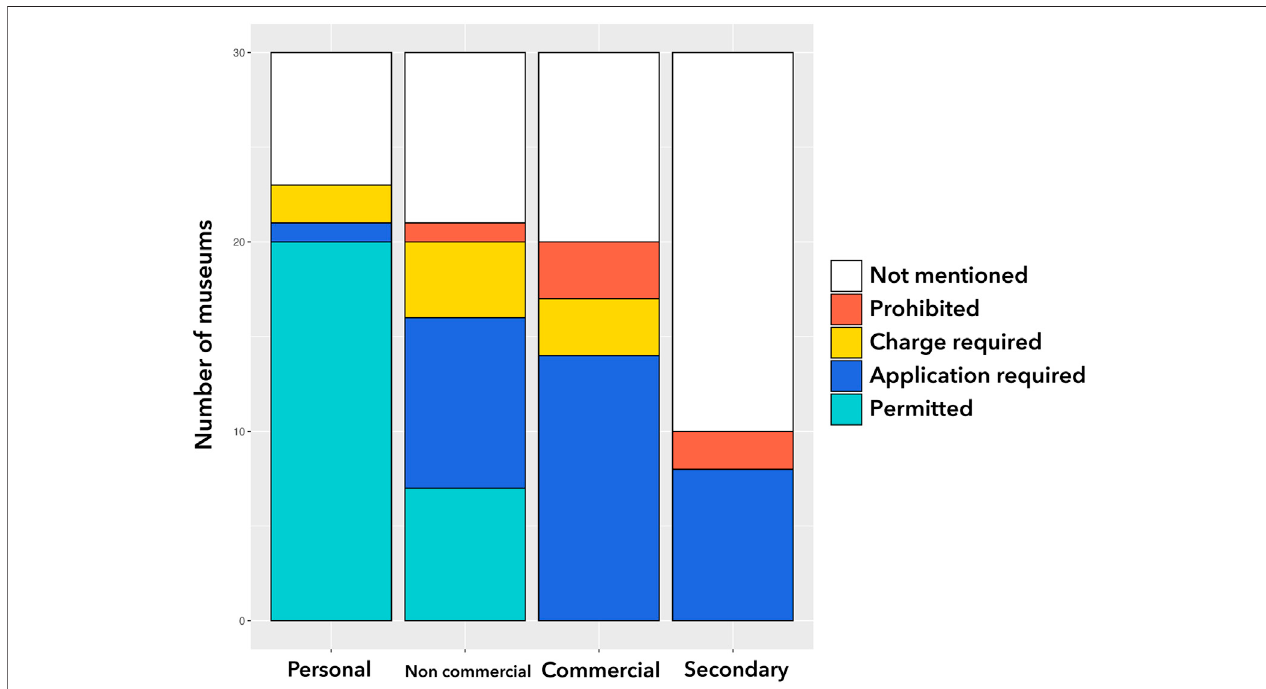
FIGURE 5 | Stacked bar charts of the generalized trend of museum policies. The data were collected from Table 1 . Legends are shown in the right side of the fi gure. These charts were created in R (R Core Team, 2021).